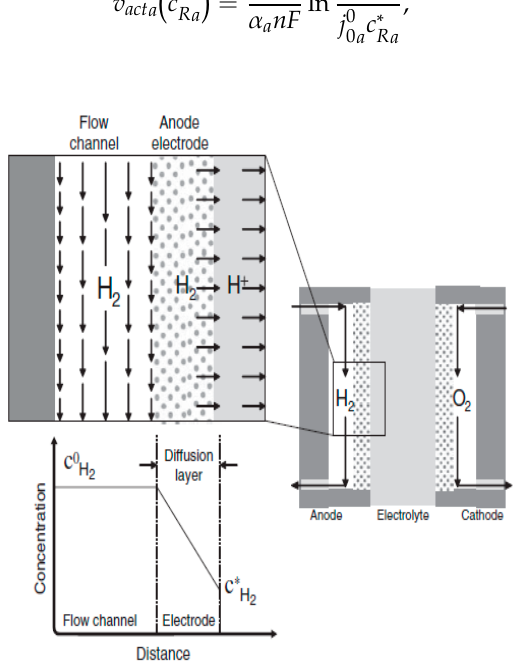
Figure 3. Diagram of the diffusion layer formed at the anode during the operation of the hydrogen ‐ oxygen fuel cell [28].